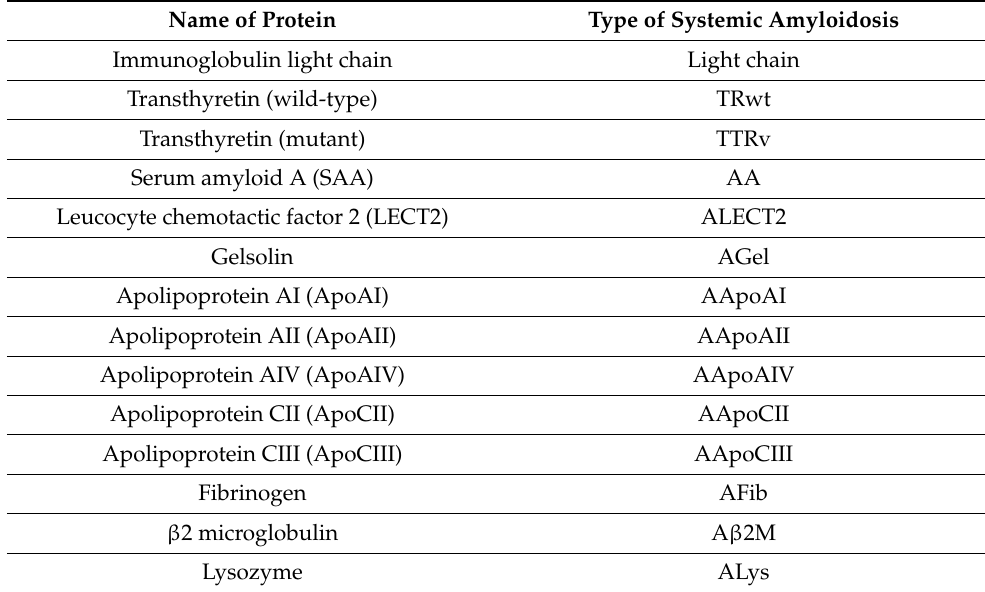
Table 1. Pathogenic proteins contributing to different types of systemic amyloidosis (based on [9]). Name of Protein Type of Systemic